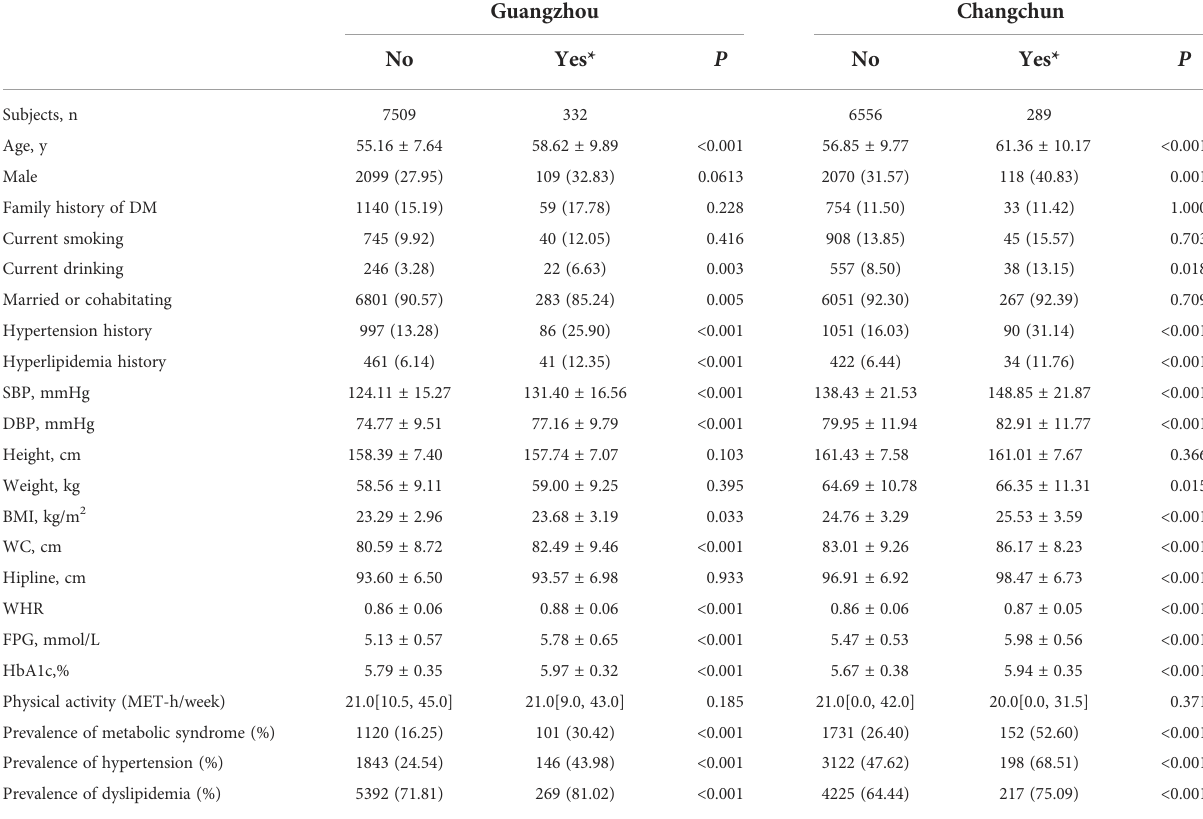
TABLE 1 Characteristics of participants in the Guangzhou and Changchun datasets in China; without and with isolated high 2-hour plasma